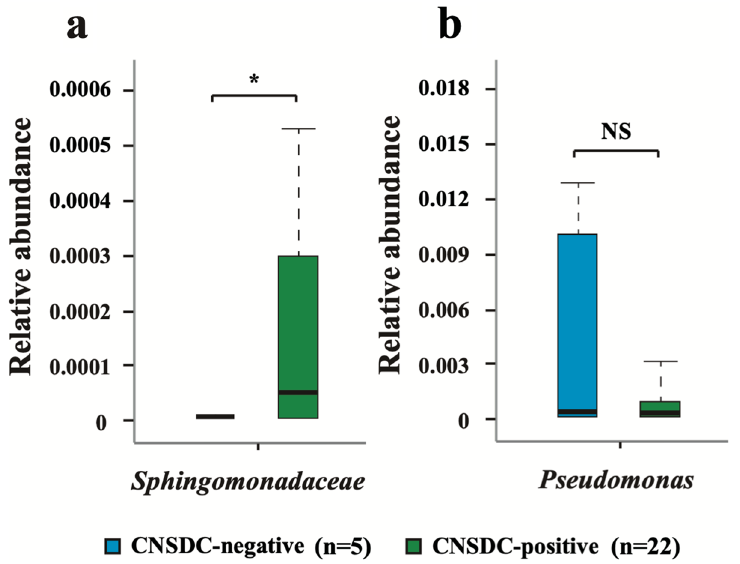
Figure 4. Relative abundance of ( a ) Sphingomonadaceae and ( b ) Pseudomonas in the CNSDC-positive PBC group compared with that in the CNSDC-negative PBC group. The values are expressed as the median of the interquartile range. * P < 0.05 compared with the CNSDC-negative PBC group. CNSDC, chronic non- suppurative destructive cholangitis; PBC, primary biliary cholangitis.